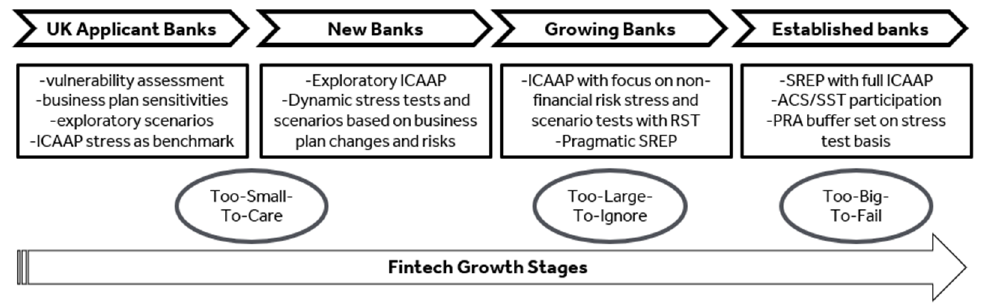
Figure 2. Fintech regulation during growth stages and banking authorisation.